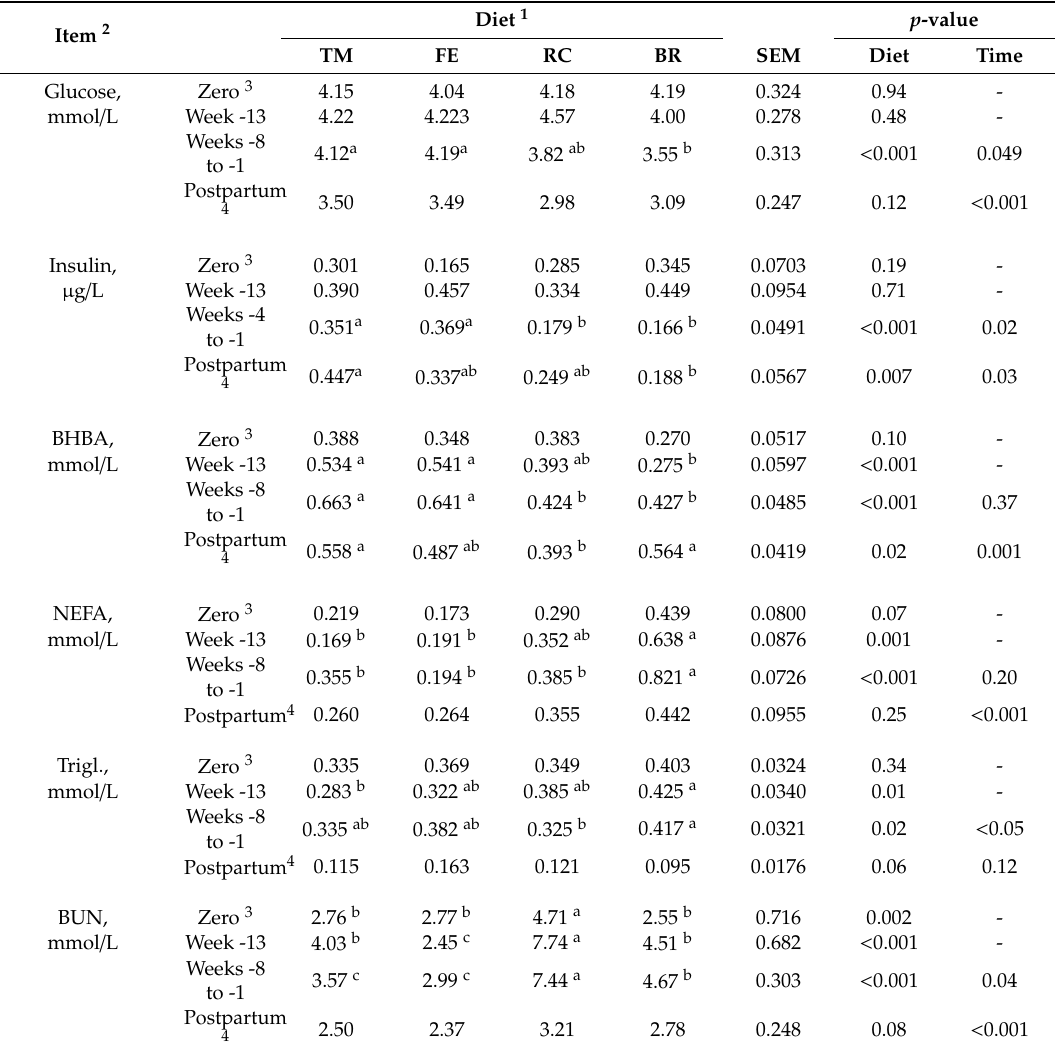
Table 5. E ff ect of prepartum experimental diet on pre- and postpartum plasma hormone and metabolite concentrations in beef